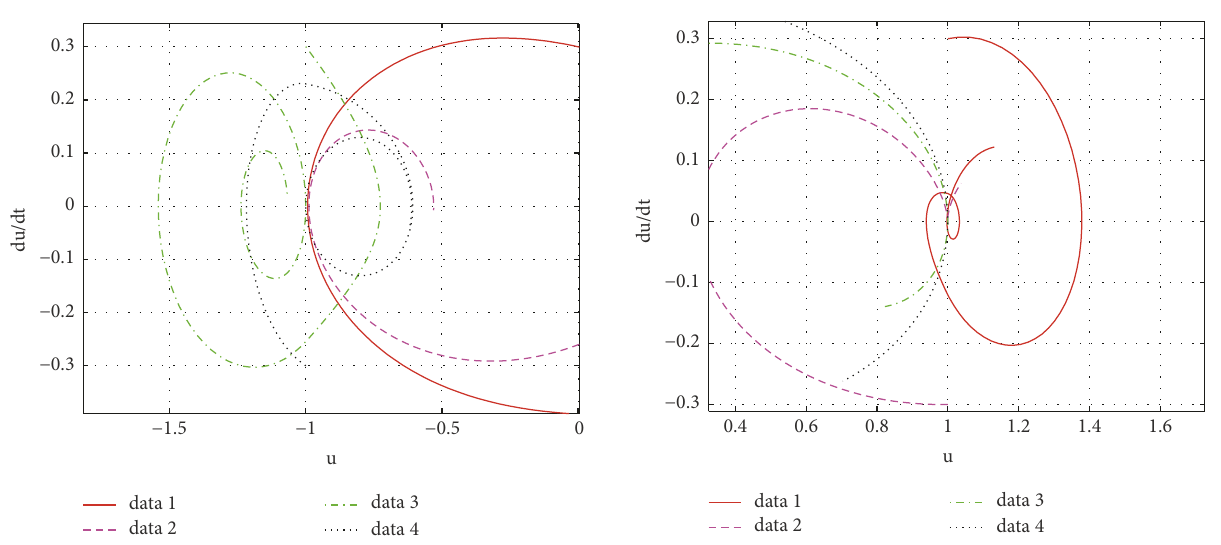
Figure 9: Combination of grazing